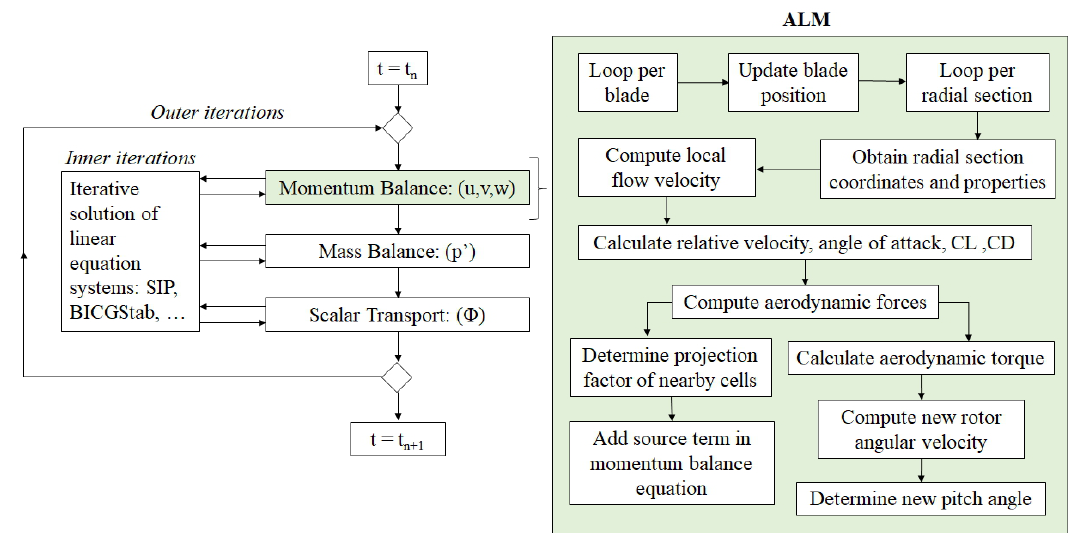
Figure 1. Iteration scheme and LES-ALM coupling for one time step (adapted from